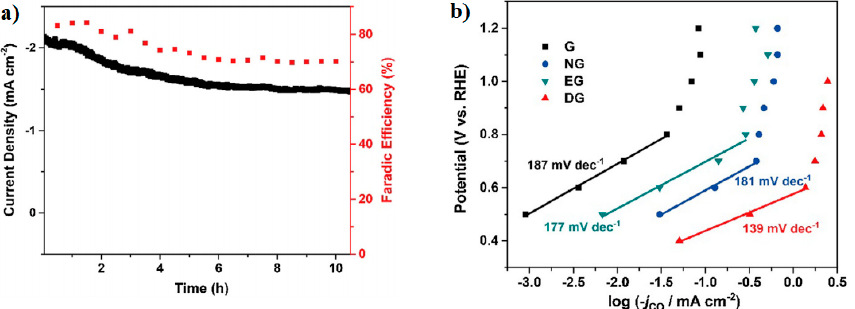
Figure 6. ( a ) Time-dependent total current density curve (left y -axis) and faradic efficiency for CO (right y -axis) at DG at − 0.6 V (vs. RHE) in 0.1 M KHCO 3 . ( b ) Tafel plots for all catalysts. Reproduced with permission